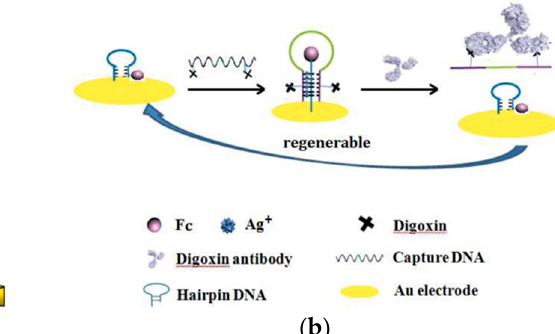
e ffi ency of antibodies other than target